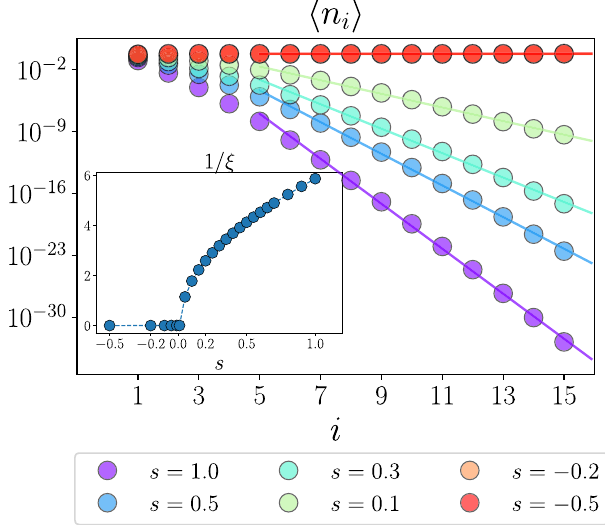
FIG. 2. Localization of the ground state for N ¼ 15 . The main plot shows the single-site occupation h n k i as a function of the position in the chain k . For positive values of s , the probability of finding an occupied spin is exponentially suppressed as the distance from the left edge increases. Inset: We fit the function (6) and plot the inverse of the localization length ξ as a function of the control parameter s